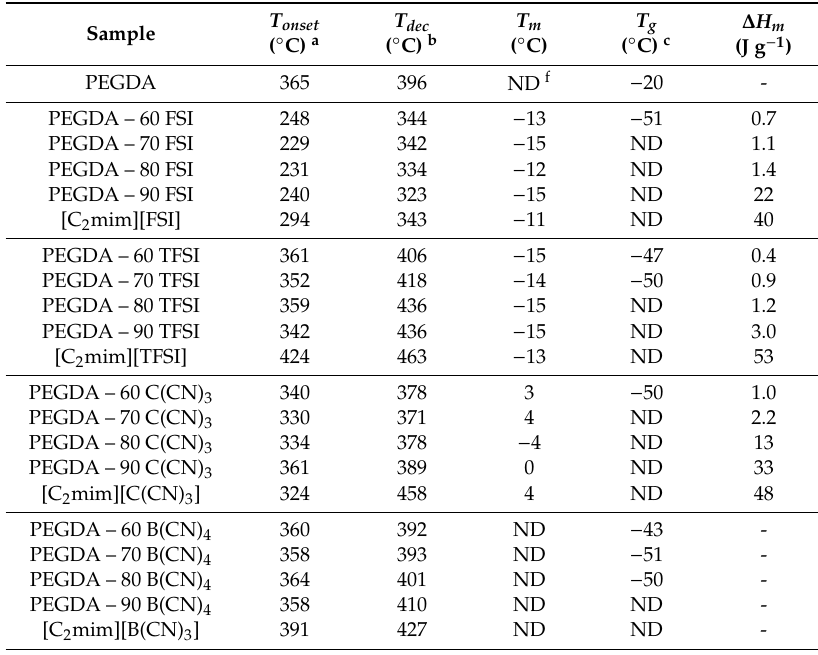
Figure 2. Images of the prepared UV-cross-linked poly(ethylene glycol) diacrylate (PEGDA) iongels. Table 1. Thermal properties of cross-linked PEGDA, neat ILs and the prepared iongels: onset ( T onset ), decomposition ( T dec ), melting ( T m ) and glass transition ( T g ) temperatures, and enthalpy of melting ( ∆ H m